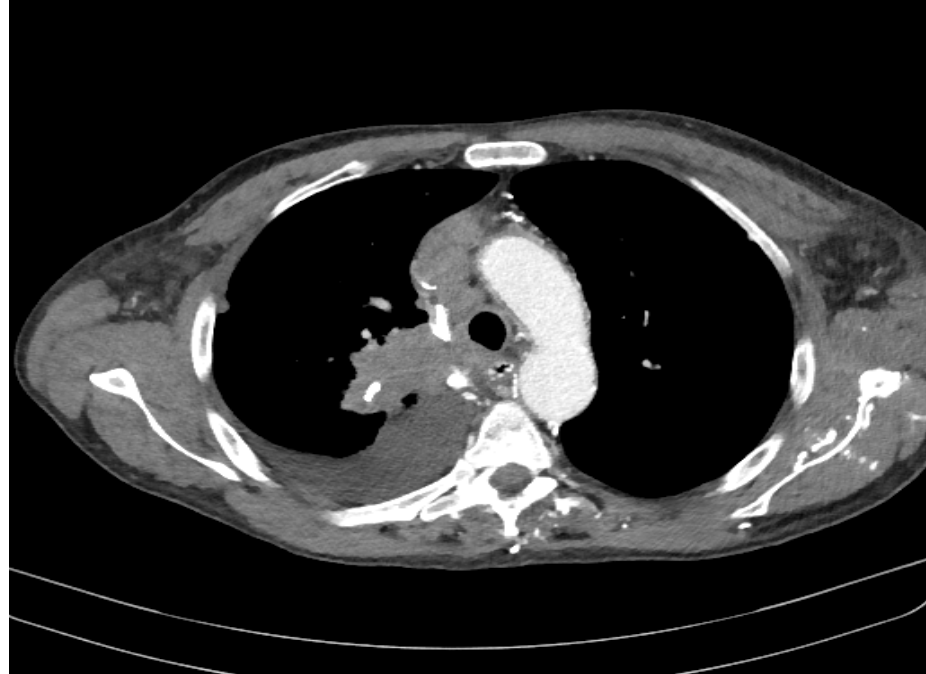
Figure 3. Computer tomography of the patient.